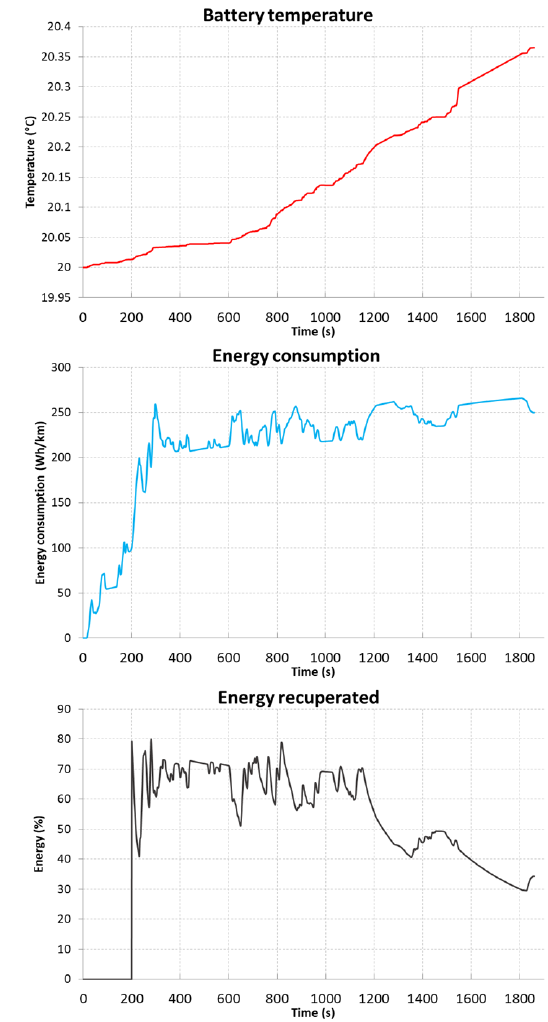
Figure 13. City Flat Road results of simulation tests for the 4 × 4 drive system with Type 1 energy storage. In the Test City Flat Road test (Figure 13), a range of 279.4 km was achieved with an energy consumption of 223.6 W/km. The energy storage during tests in this profile of use is evenly loaded with the current due to the relatively low speed, frequent braking, and